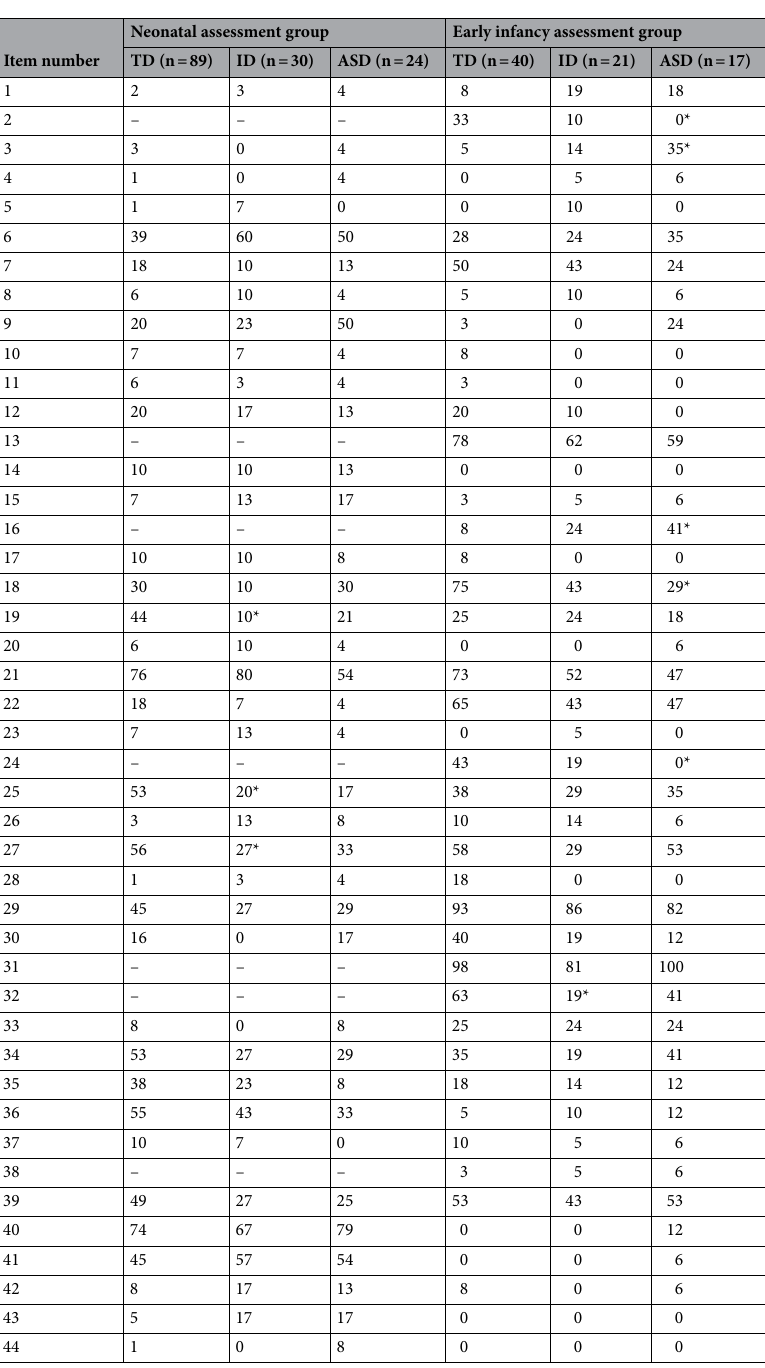
Table 3. Percentage of presence behaviour in all items by group in the neonatal and early infancy assessment. TD typical development, ID intellectual disability, ASD autism spectrum disorder. * p < 0.05 in comparison with TD group using the Fisher’s exact test (corrected by the Benjamini–Hochberg